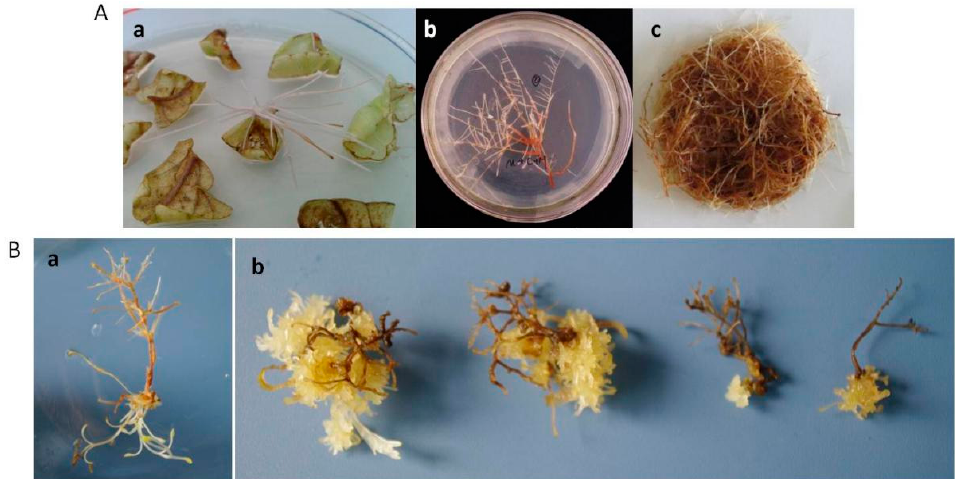
Figure 7. Phenotype comparisons between the RNA interference lines and WT hairy roots. ( Aa ) WT hairy root emerged on the edge of leaves; ( Ab ) single hairy root grew many branches when subcultured on MS solid medium; ( Ac ) WT hairy roots were removed from 6,7-V liquid medium after two month; ( Ba ) single RNAi hairy root was transferred to MS solid medium; ( Bb ) SmIPI1 interference hairy roots were removed from shake flasks cultures after two months.